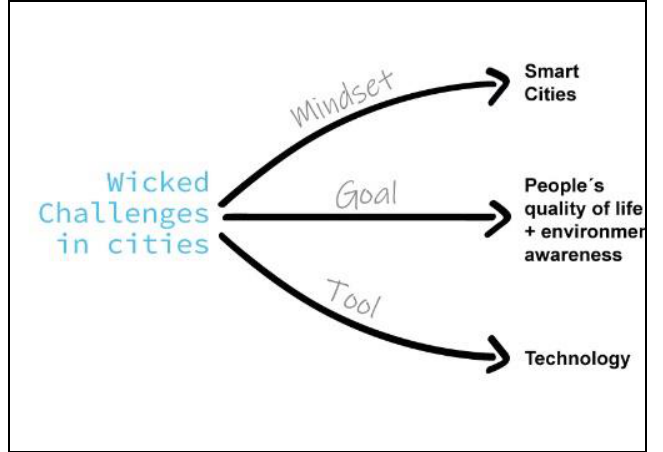
Figure 5. The essential of the smart city ’ s concept.